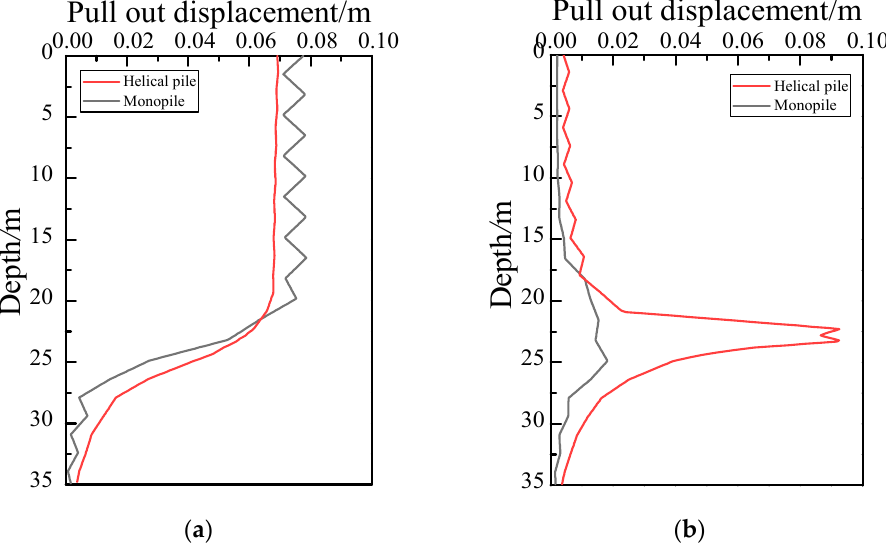
Figure 11. Soil stress inside and outside pile varies with depth. ( a ) Soil stress in pile; ( b ) Soil stress outside